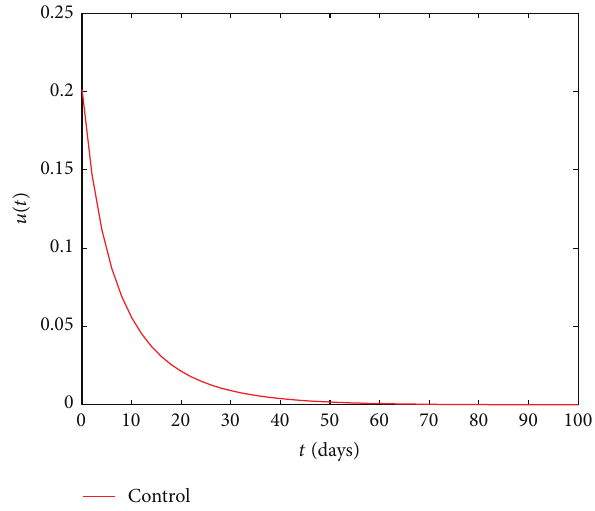
Figure 12: The optimal control 𝑢 for problem